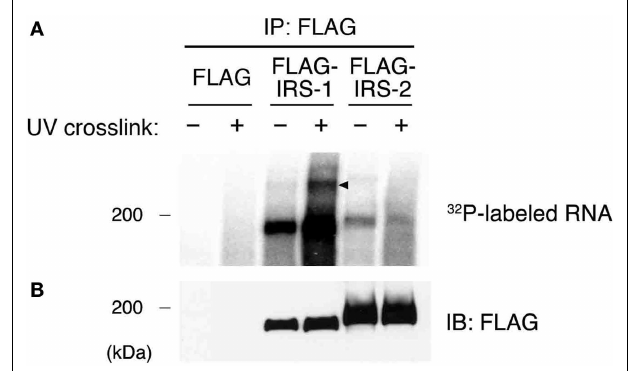
FIGURE 1 | Purification of IRS-1-RNA complexes by CLIP . (A) HEK293 cells expressing FLAG–IRS-1 or IRS-2 were irradiated with or without UV. Protein–RNA complexes were immunoprecipitated with anti-FLAG antibody, and the 5 (cid:48) ends of immunoprecipitated RNAs were radiolabeled with 32 P. Proteins cross-linked with radiolabeled RNAs were separated by SDS-PAGE and visualized by autoradiography. Representative autoradiograms from three experiments are shown. RNA–protein complexes of ~200kDa (arrowhead) are seen with FLAG–IRS-1 immunoprecipitates (IP) dependent on UV irradiation but not control and FLAG–IRS-2 IP. (B) Immunoblot (IB) analysis of IRS-1 and IRS-2 IP using anti-FLAG antibody.